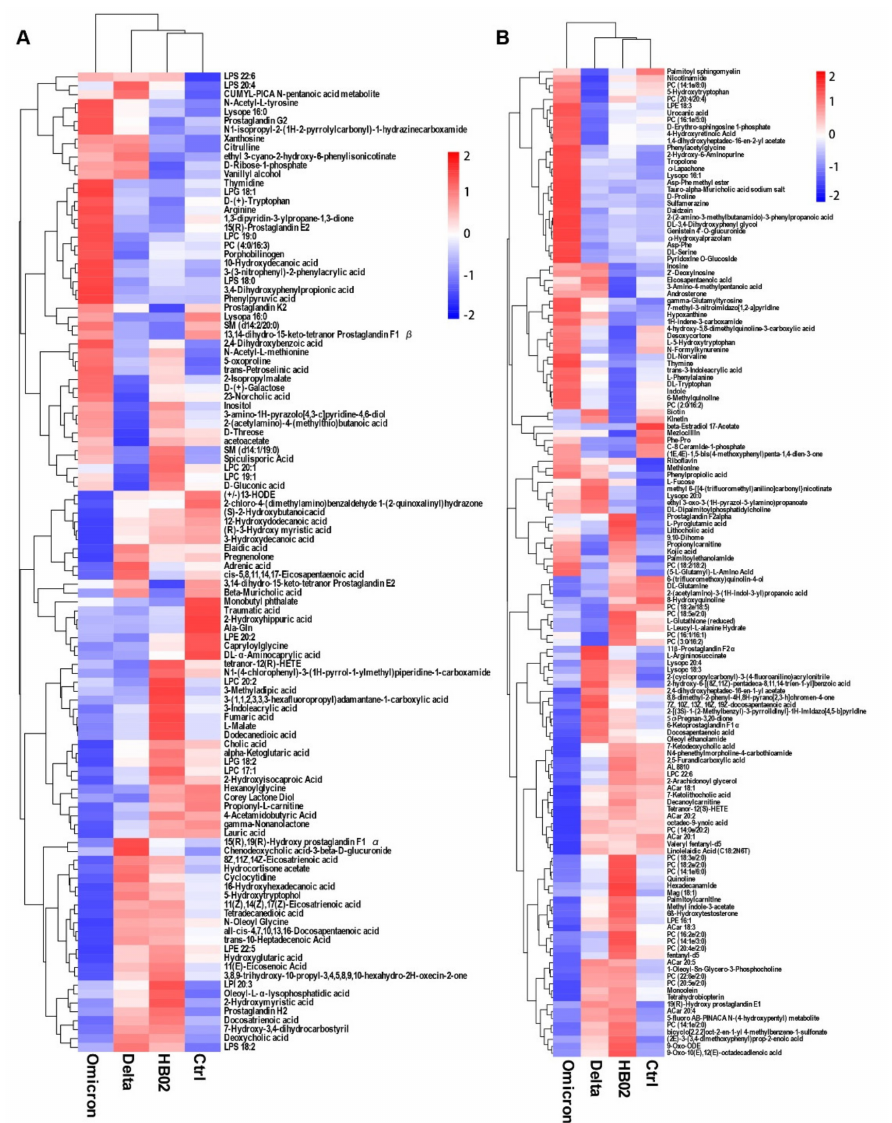
Figure 3. The change in the metabolism induced by vaccines. ( A ) The positive ion of the metabolism in the serum of the mice immunized with different vaccines on day 42. ( B ) The negative ion of the metabolism in the serum of the mice immunized with different vaccines on day 42. Numbers − 2 to 2, z-values, represent the relative expression of differentially expressed